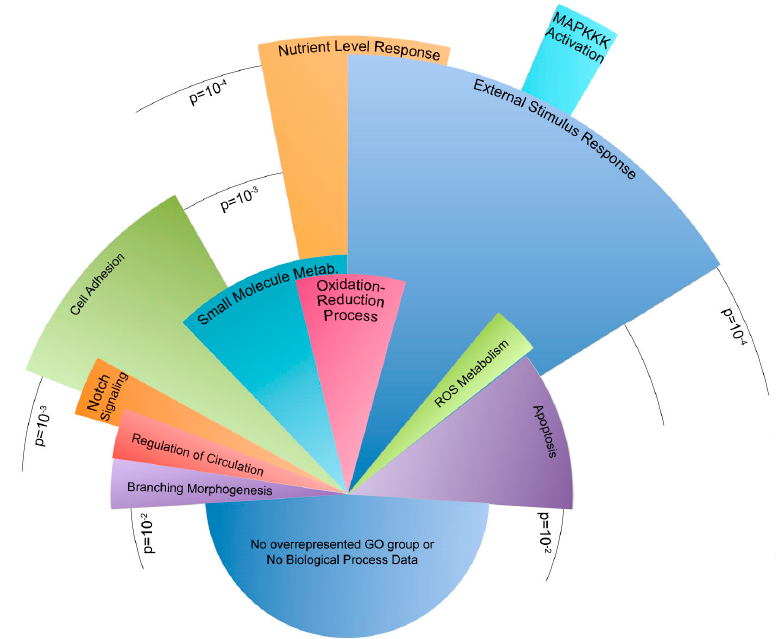
Figure 5. Incongruent genes dysregulated in Bmpr2 R899X endothelial cells after 24 h of perfusion. Pie chart shows relative number of genes in statistically dysregulated gene ontology groups. Arc length of the gene ontology groups corresponds to the number of genes present in each group. Radius length corresponds to significance, where the longest categories were significantly dysregulated at ~ p < 1 × 10 − 5 and the shortest categories were dysregulated at p < 1 × 10 − 2 . Please see the Supplementary Materials for a table of these findings.